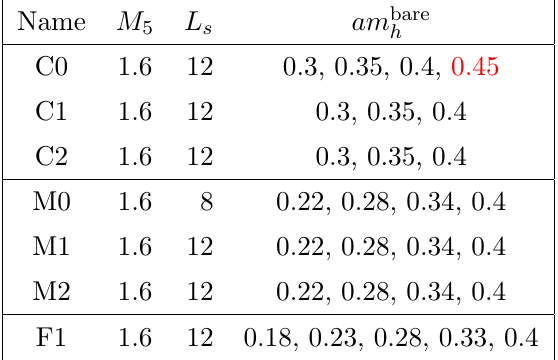
Table 3 . M(cid:127)obius domain wall parameters for the heavy quarks on all ensembles. All quoted values for am h are bare quark masses in lattice units. As described in the text, the value indicated in red was only used to verify our assumptions about the applicability of the quenched pilot study to the dynamical